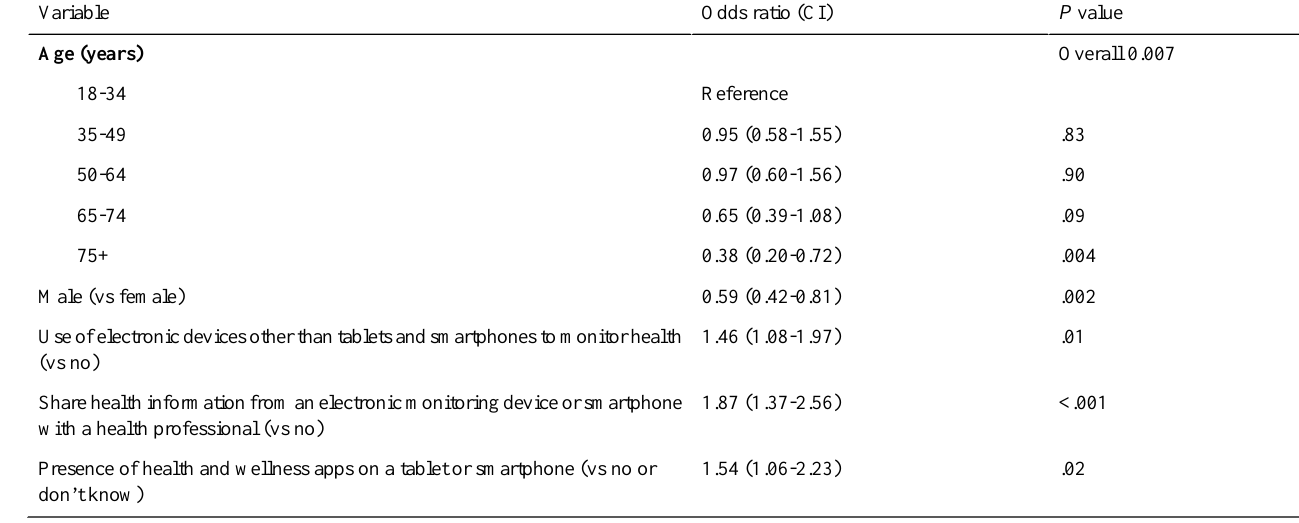
Table 2. Multivariable logistic regression model for using a tablet or smartphone to help make decisions about how to treat an illness or